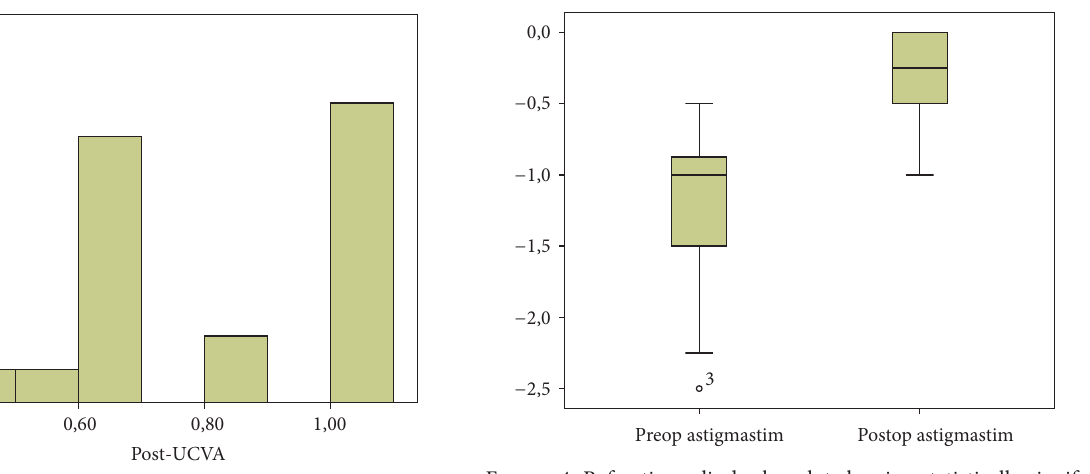
Figure 3: Histogram showing the distribution of postoperative UCVA: 86% of the participants exhibited vision acuity of 0.6 or higher.